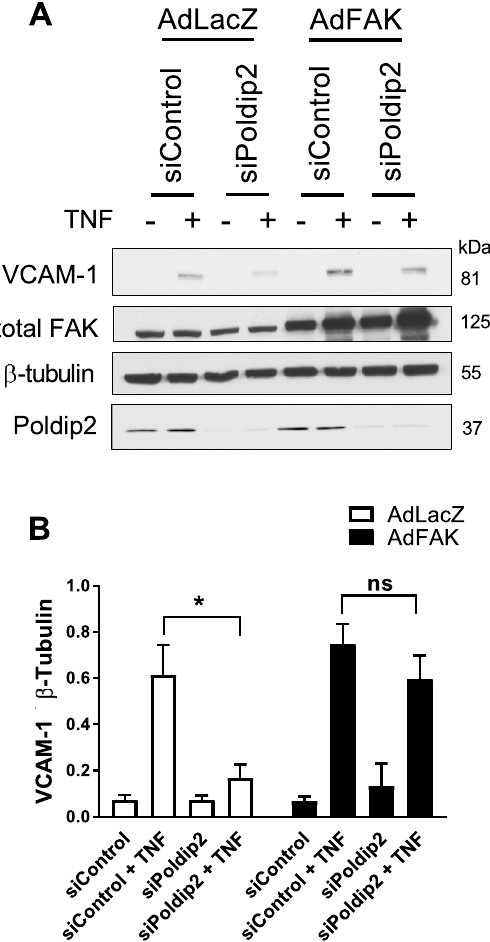
Figure 6. FAK activity mediates TNF-induced VCAM-1 upregulation. Seventy-80% confluent RBMECs were transfected with siControl or siPoldip2 and the following day transduced with AdFAK or AdLacZ (control